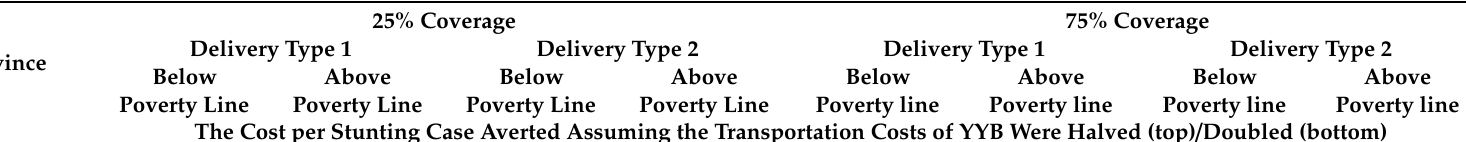
Table 5. Cost-e ff ectiveness of YYB program, by province and poverty status, when the transportation costs (for both Delivery Type 1 and Delivery Type 2) are halved or doubled (Cost (¥) per stunting case